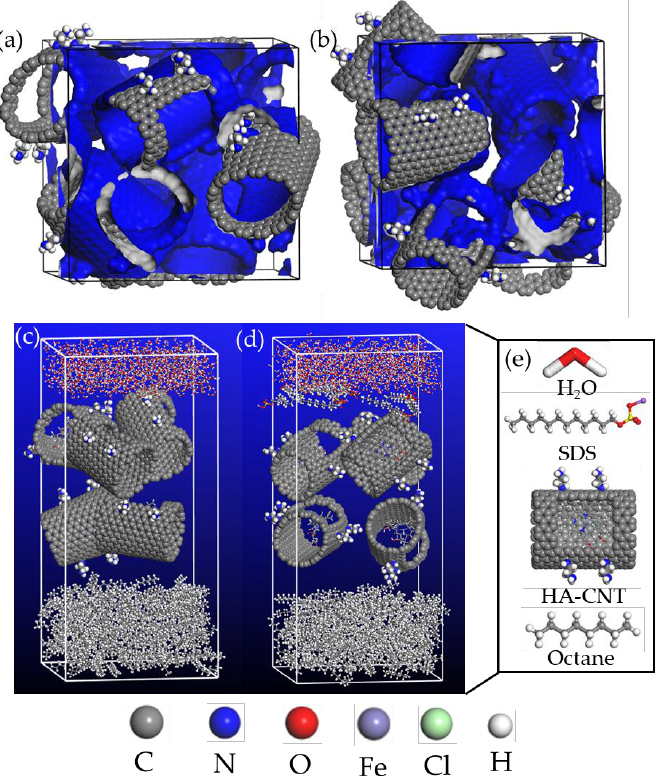
Figure 1. The energy-minimized amorphous cells consisting of 7 units of ( a ) the NH 2 -CNT, and ( b ) the HA-MWCNT active layers. The starting geometry of the ( c ) membrane-oil–water and the ( d ) emulsified membrane-oil–water systems. The respective components of water, surfactant, membrane active layer, and the oil model are shown in ( e